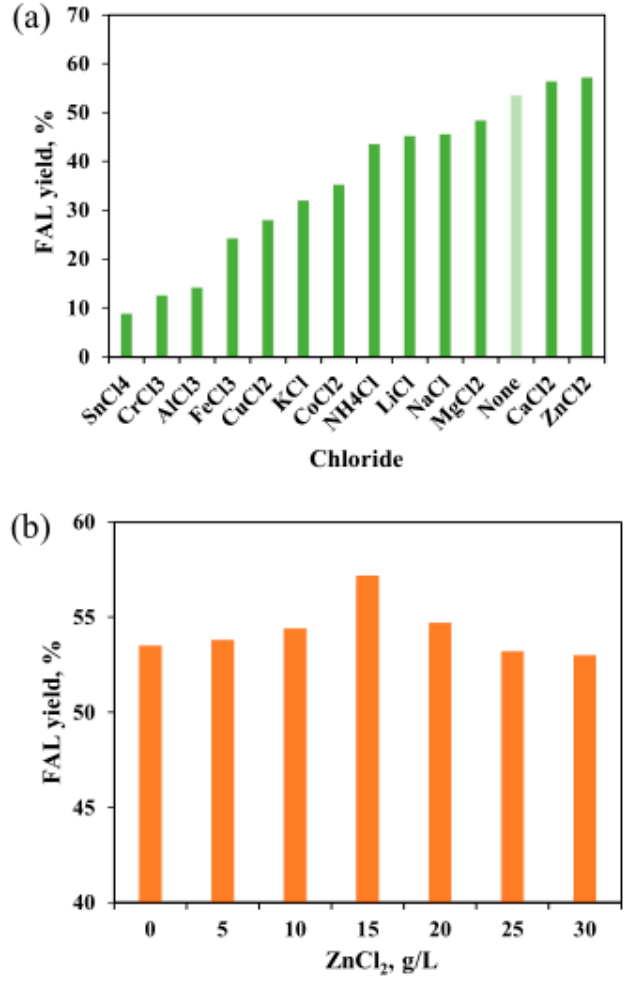
Figure 8. Effects of chlorides (15 g/L) on the FAL production in ChCl:PEG10000–water (20:80, wt/wt) (corn stover 75 g/L, solid acid 1.2 wt%, 170 ◦ C, 30 min) ( a ); effects of ZnCl 2 loading (0–30 g/L) on the FAL production in ChCl:PEG10000–water (20:80, wt/wt) (corn stover 75 g/L, solid acid 1.2 wt%, 170 ◦ C, 30 min) ( b ).